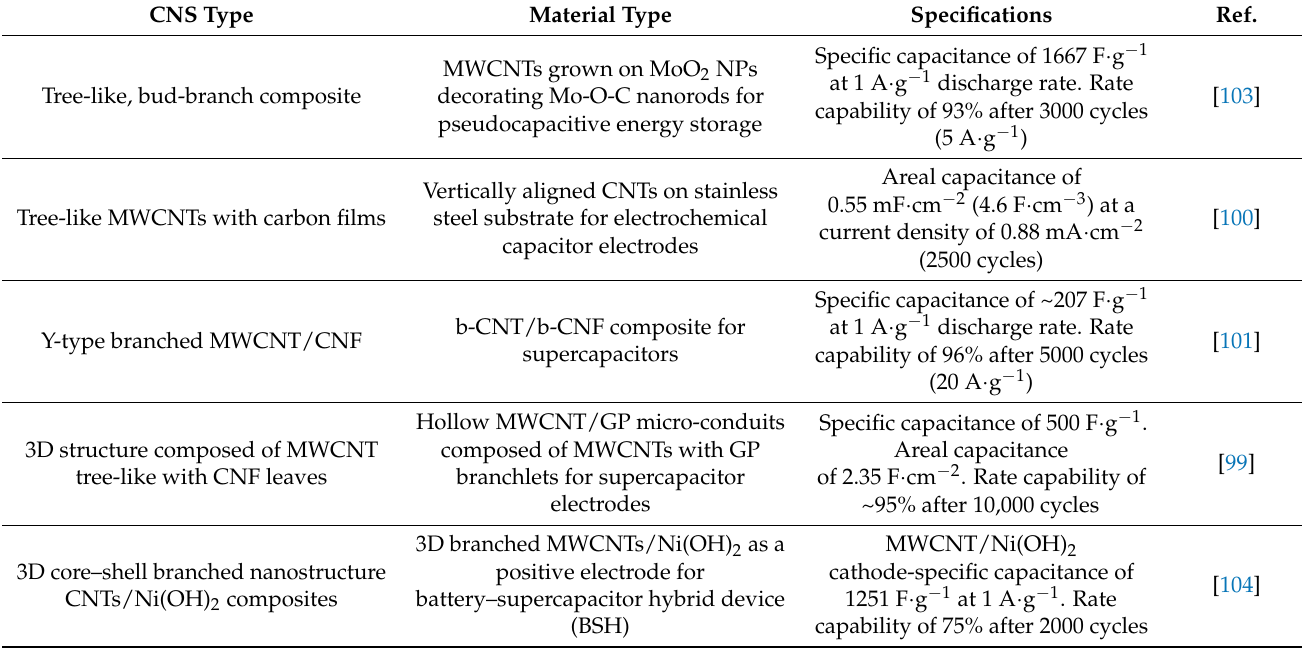
Table 3. Examples of branched CNSs used in supercapacitor technology.